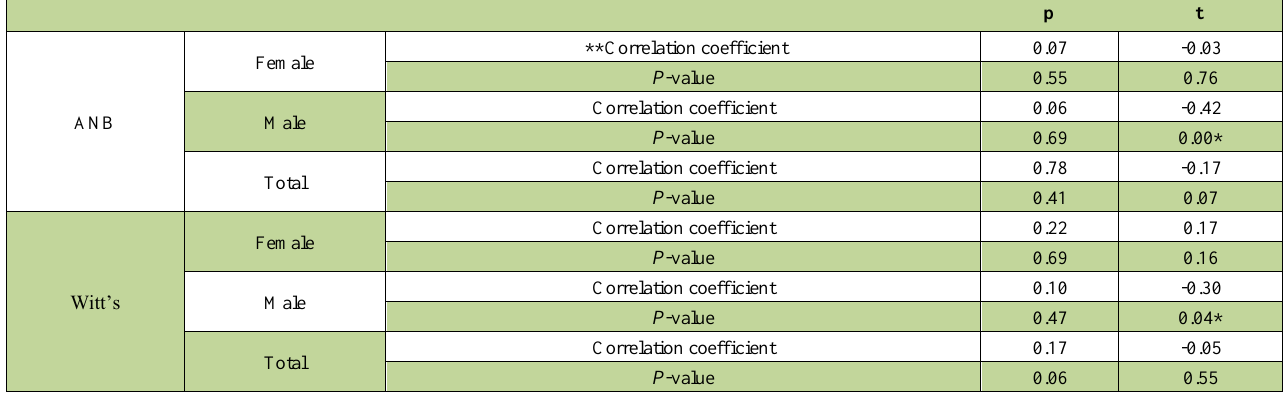
Table 2. Relationships between the values of Witt's, ANB, p, and t indices by gender.